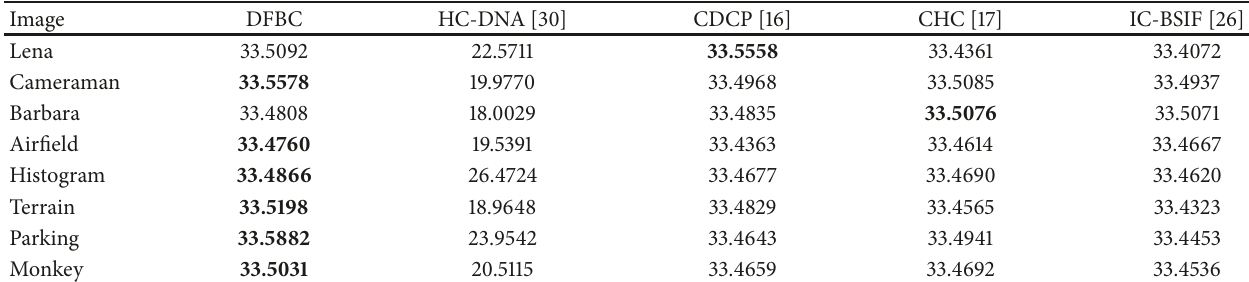
Table 5: The average UACI (%) of running the schemes 10